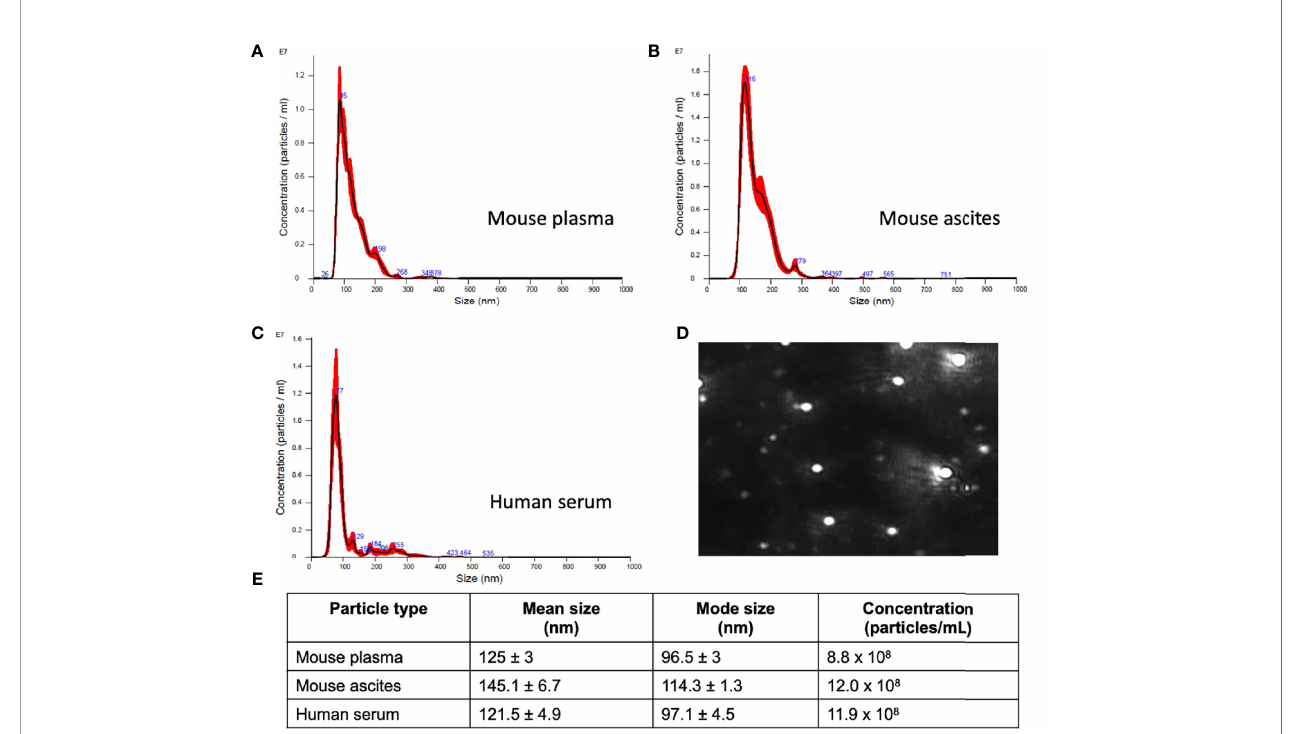
FIGURE 2 | Small extracellular vesicle (sEV) isolation from mouse plasma, ascites, and human plasma shows similar sized populations independent of bio fl uid. Representative sizing of vesicles isolated from (A) mouse plasma, (B) mouse ascites, and (C) human serum. (D) Representative image of mouse plasma vesicles on the Nanosight NS300. (E) sEV from plasma from mice had an average mode size of 96.5 ± 3 nm and concentration of 8.8x10 8 particles/ml. sEV from ascites from mice had an average mode size of 114.3 ± 1.3nm and a concentration of 12.0x10 8 particles/ml. sEV from human serum had an average mode size of 97.1 ± 4.5nm and a concentration of 11.9x10 8